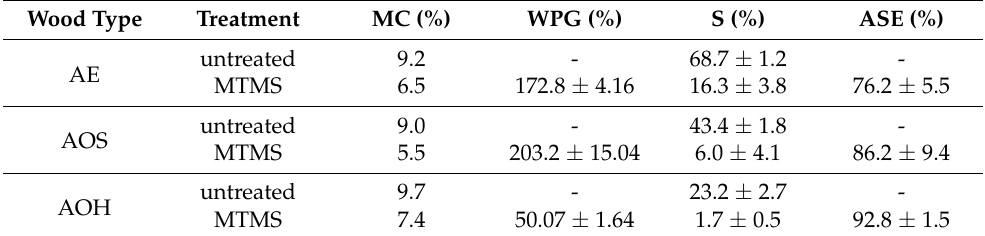
Table 1. Average values of the moisture content (MC) at room temperature, weight percent gain (WPG), volumetric shrinkage (S) and volumetric anti-shrink efficiency (ASE) of archaeological air- dried elm heartwood (AE), oak sapwood (AOS) and oak heartwood (AOH) untreated and treated with